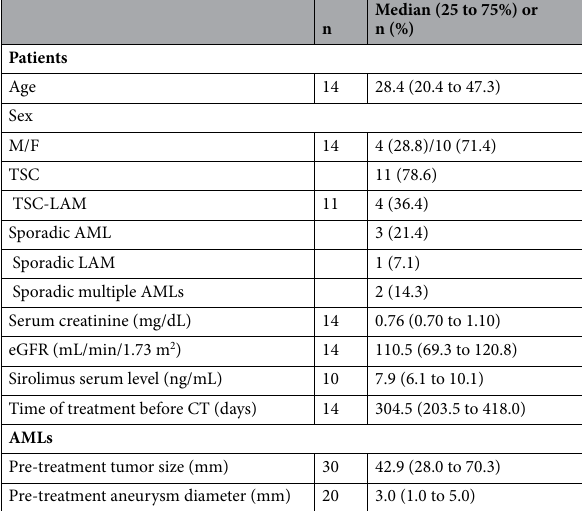
Table 1. Characterization of patients and angiomyolipomas. AML angiomyolipoma, CT computed tomography, eGFR estimated glomerular filtration rate, LAM lymphangioleiomyomatosis, M/F male/female, TSC tuberous sclerosis